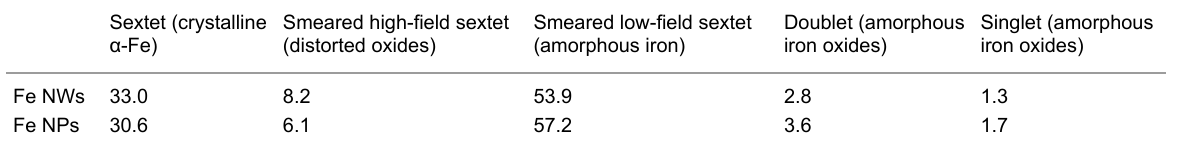
Table 2: The relative contribution in percent of iron atoms belonging to the individual phases derived from Mössbauer studies (the components of intensity below 1% have been omitted). Sextet (crystalline α